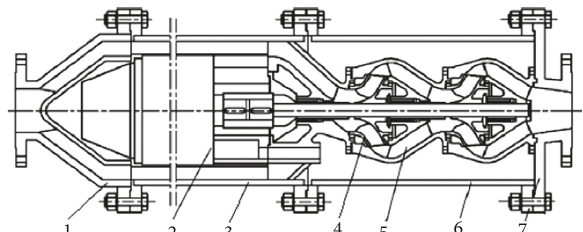
Figure 1: Overall structure of the two-stage electric lifting pump. 1, inlet flange; 2, motor; 3, motor cylinder body; 4, impeller; 5, diffuser; 6, pump cylinder body; 7, outlet